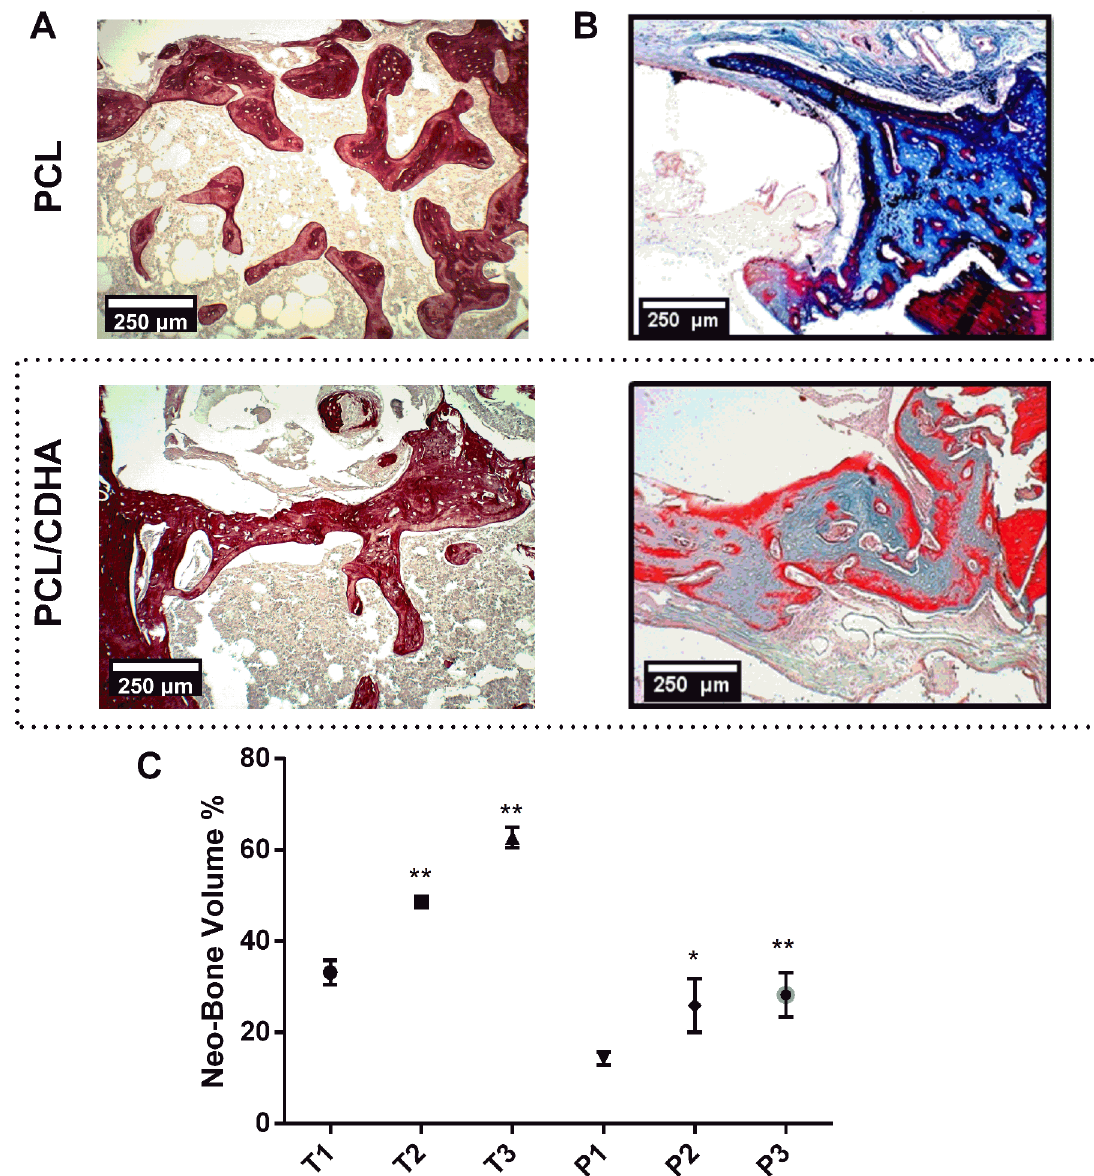
Figure 3. Histological data: A) Tibia groups with biomaterials PCL and PCL/CDHA, T2 and T3, respectively; B) Parietal groups, P2 and P3, 250 μm scale bar; C) Quantification of neobone volume.* ’s Indicates statistical differences between the control and the